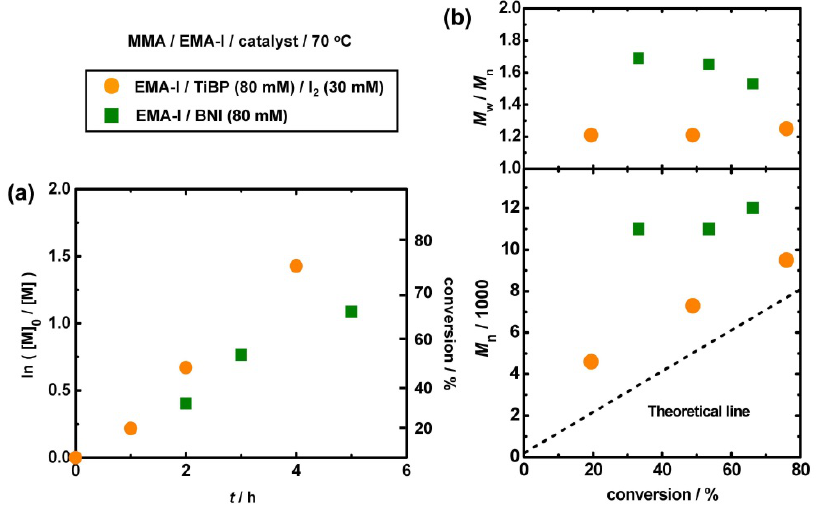
Figure 4. Plots of ( a ) ln([M] /[M]) vs. t and ( b ) M 0 MMA/R–I/catalyst systems (in bulk) (70 °C): [MMA] [catalyst] = 80 mM. The catalysts and the symbols are as indicated in the figure. For the 0 TiBP systems, I (30 mM) was 2